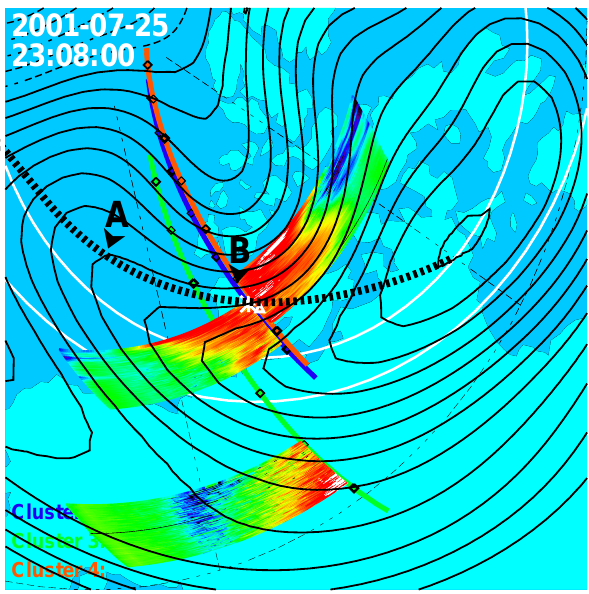
Fig. 4. Composite plot of Cluster magnetic footpoints and iono- spheric convection streamlines for 25 July 2001, at 23:08UT. Over- layed on the magnetic footpoints are 14min wide sections of the Cluster/CIS flux measurements presented in Plate 1, which are cen- tered on the actual position of the Cluster satellites at 23:08UT. Also indicated by a dashed line is the most likely position of the ion open-closed field line boundary based on the location of the Cluster SC4 satellite position, which entered the cusp at that time, and the SuperDARN convection pattern.